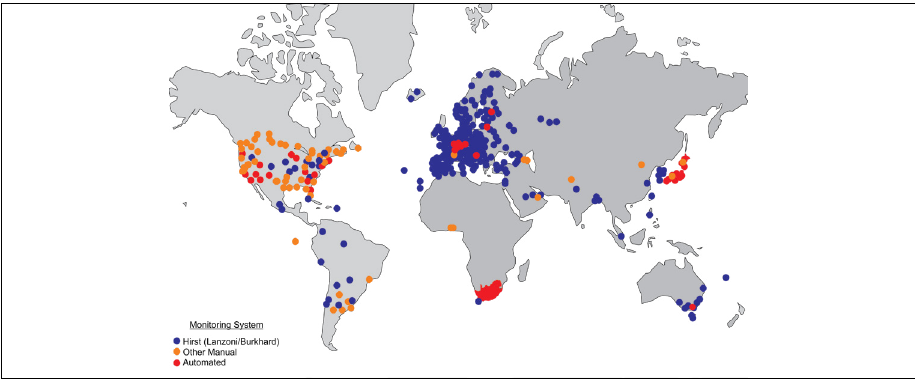
Figure 1: Global map of aerospora monitoring stations. Area in red represents South Africa and